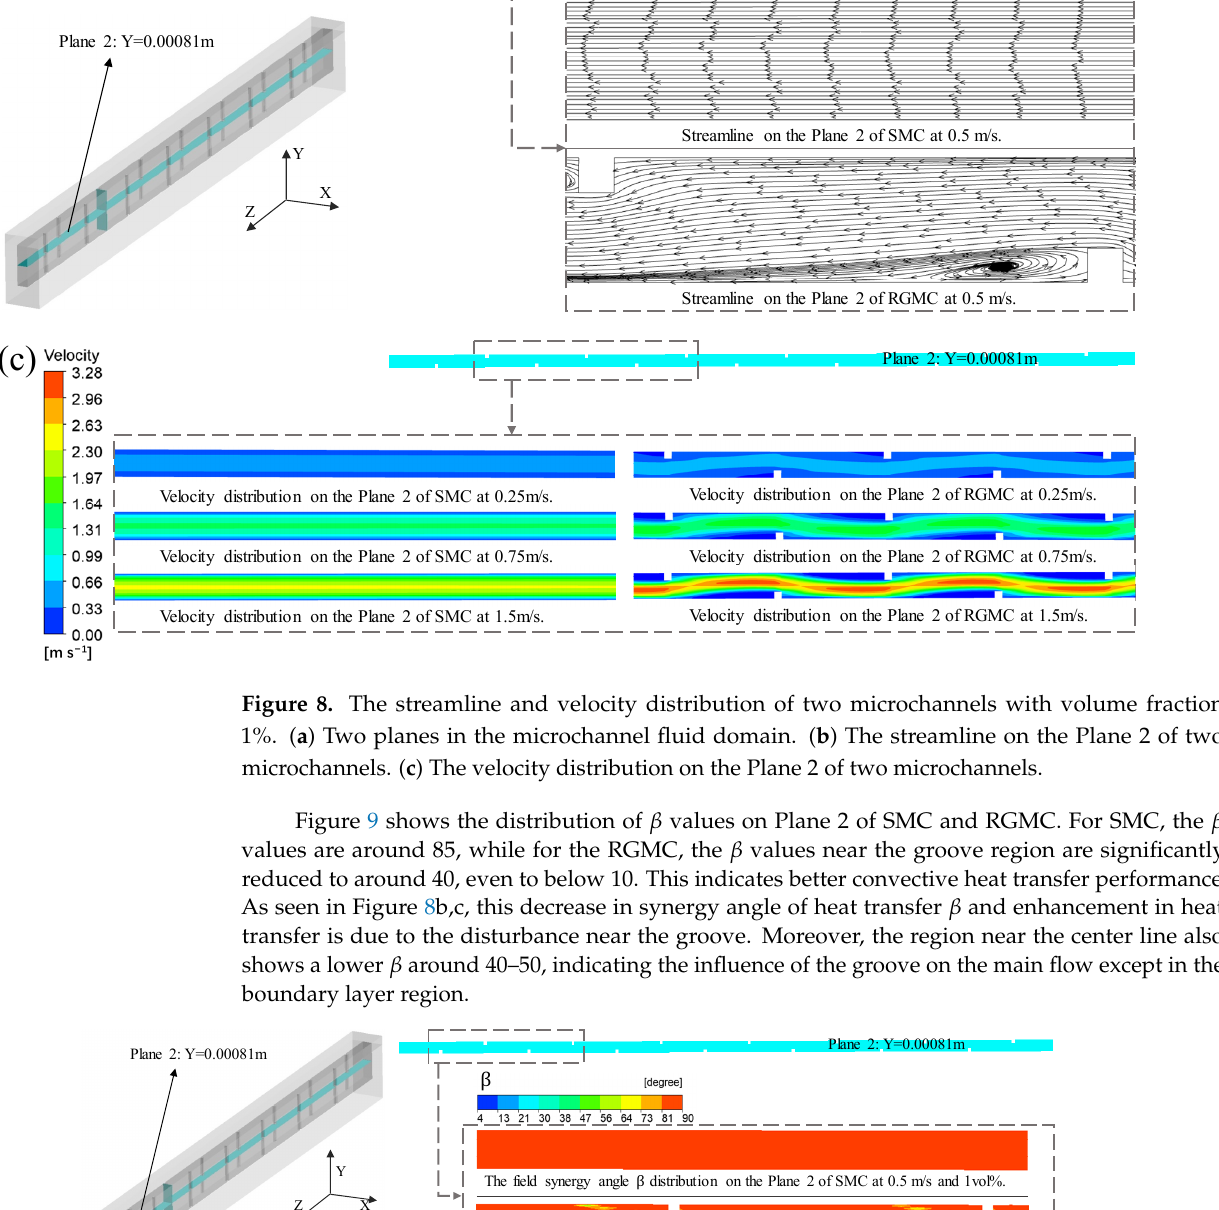
Figure 9. Distribution of field synergy angles 𝛽 .